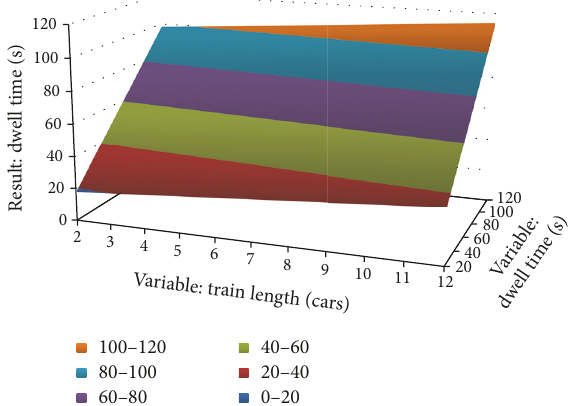
Figure 7: The results from changing the variables in the Beijing railway stations.